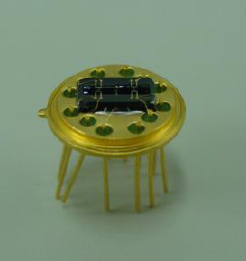
Figure 5. Fabricated sensor prototype without